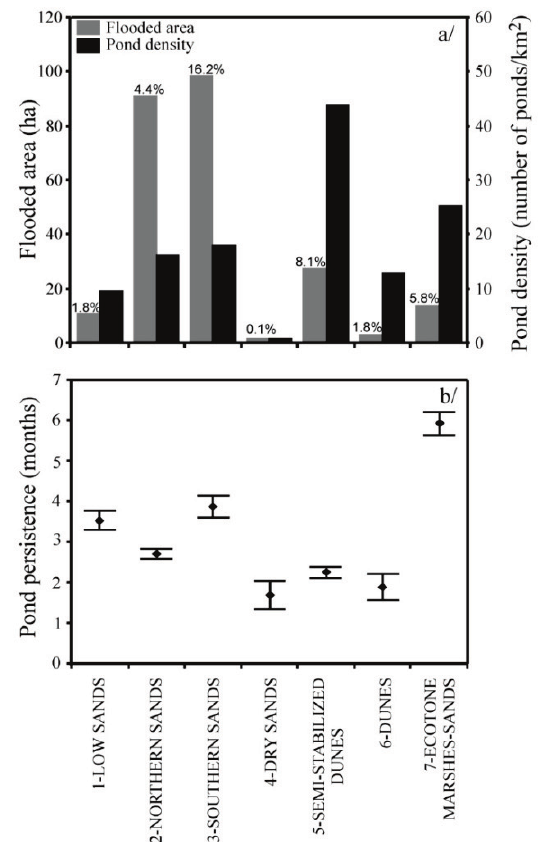
Figure 3. (a) Flooded area and temporary pond density (number of temporary ponds/km 2 ) predicted for each ecosection at the time of the largest flood event in the study area (February 15th, 1990), as predicted from Landsat data. The percentage of flooded area is also shown. (b) Mean and standard error of average hydroperiod for each